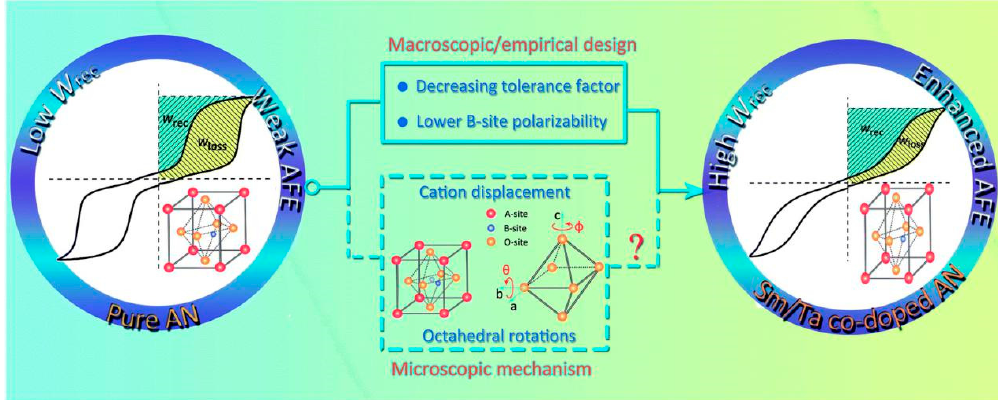
Figure 16. Schematic diagram of (Sm 0.02 Ag 0.94 )(Nb 0.9 Ta 0.1 )O 3 enhancing W rec by increasing the stability of AFE phase in this study. Reprinted with permission from [77]. Copyright 2019 Royal Society of Chemistry.